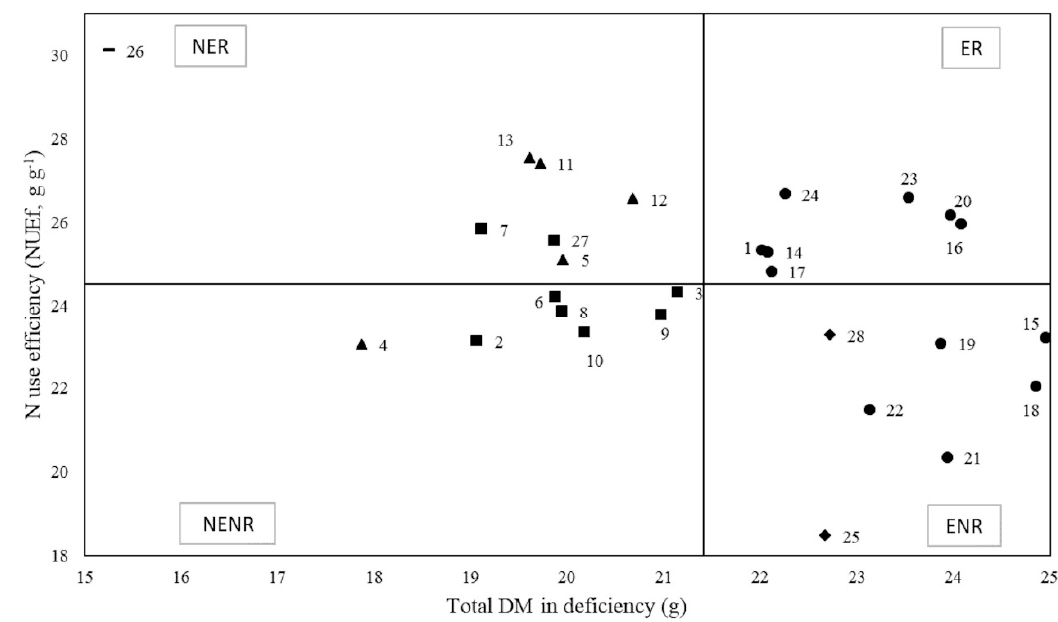
Figure 1. Classification of the 28 tobacco genotypes in response to the total dry mass (DM) produced under N deficiency (g) and the responsiveness to N supply (NUEf; g g − 1 ). Internal lines represent the mean values for the axis of all genotypes. The Virginia, Burley, Comum, Maryland, and Dark varietal groups are represented by circles, squares, triangles, rhombs, and lines, respectively. ER, e ffi cient and responsive; ENR, e ffi cient and non-responsive; NER, ine ffi cient and responsive; NENR, ine ffi cient and non-responsive. For genotypes and their respective numbering, refer to Table S1.